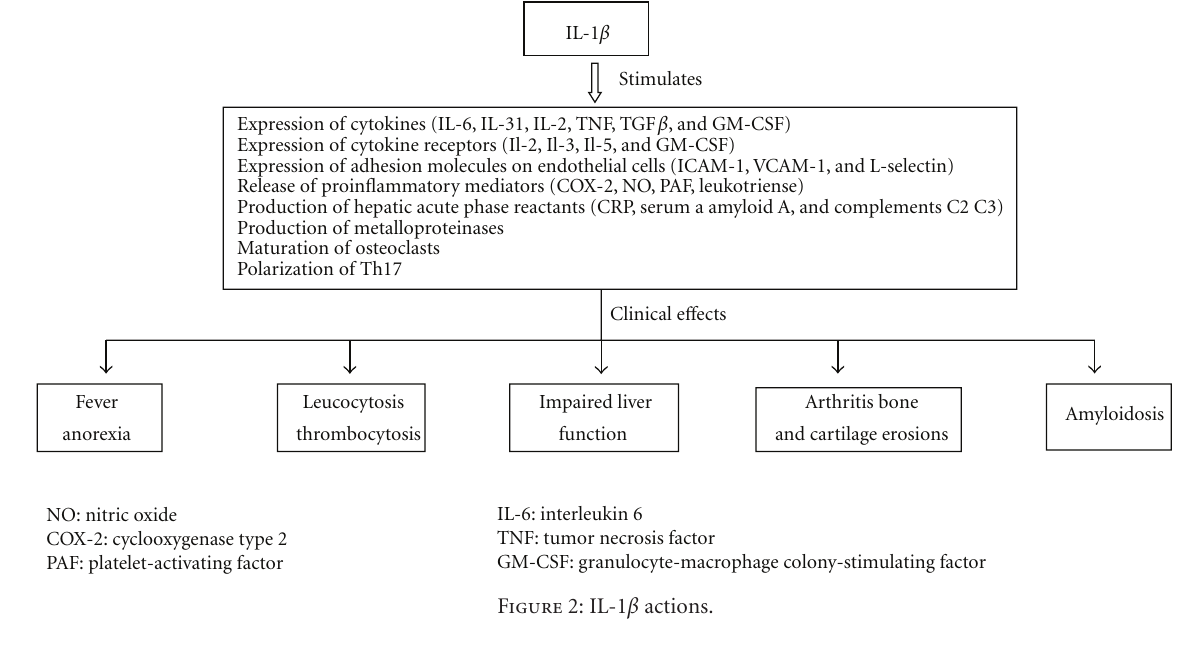
Figure 2: IL-1 β